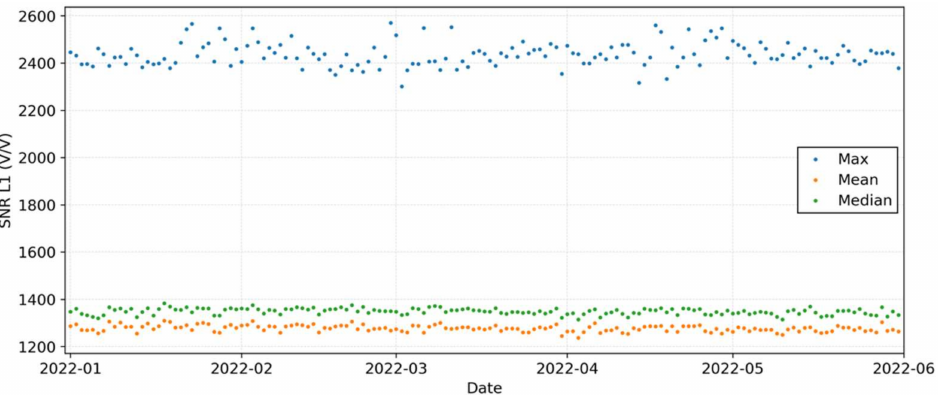
Figure 3. Max, mean, and median daily high-altitude SNR for neutral atmosphere profiles in 2022. For each profile, SNR is averaged between 60–80